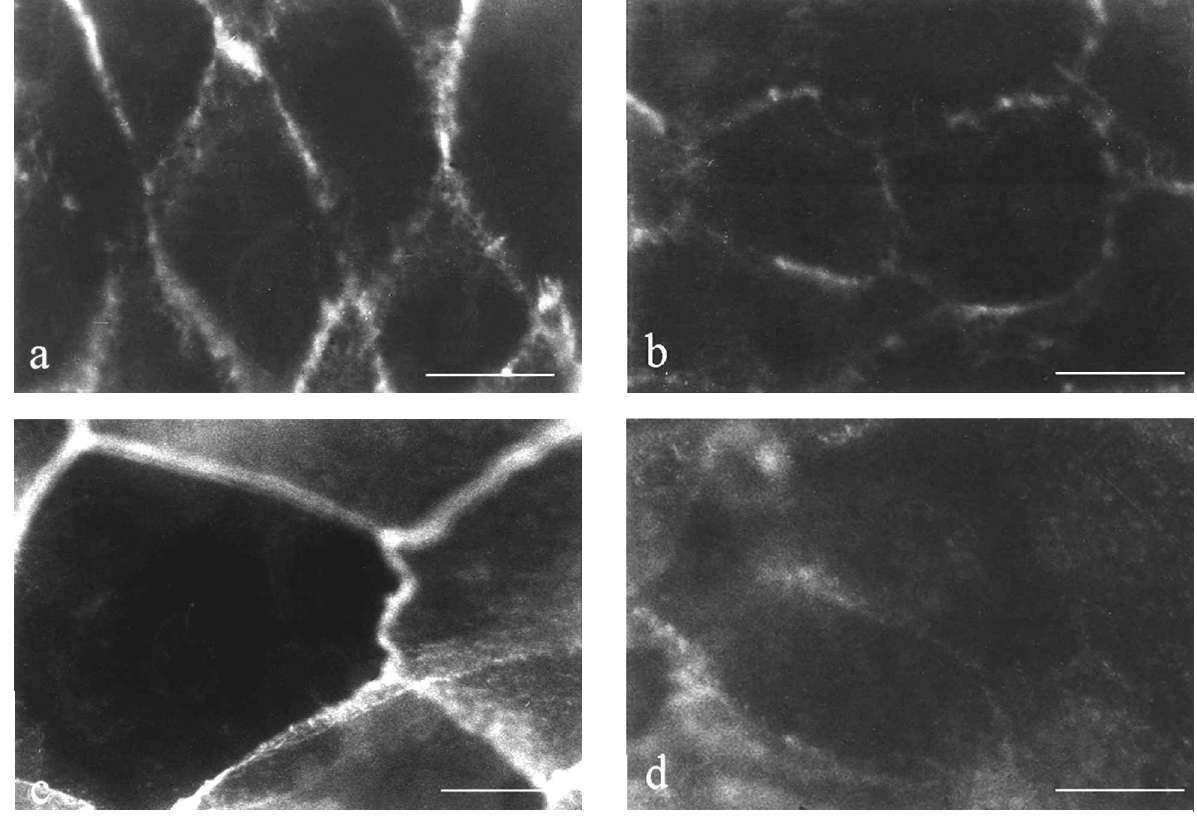
FIG. 8. Immunocytochemistry of plakoglobin (desmosomes) in (a) 16HBE14o– control cells and (b) 16HBE14o– cells exposed to poly- L -arginine, and in (c) NHBE control cells and (d) NHBE cells exposed to poly- L -arginine. Note decreased staining for desmosomal protein after exposure to poly- L -arginine. Bar = 40 m